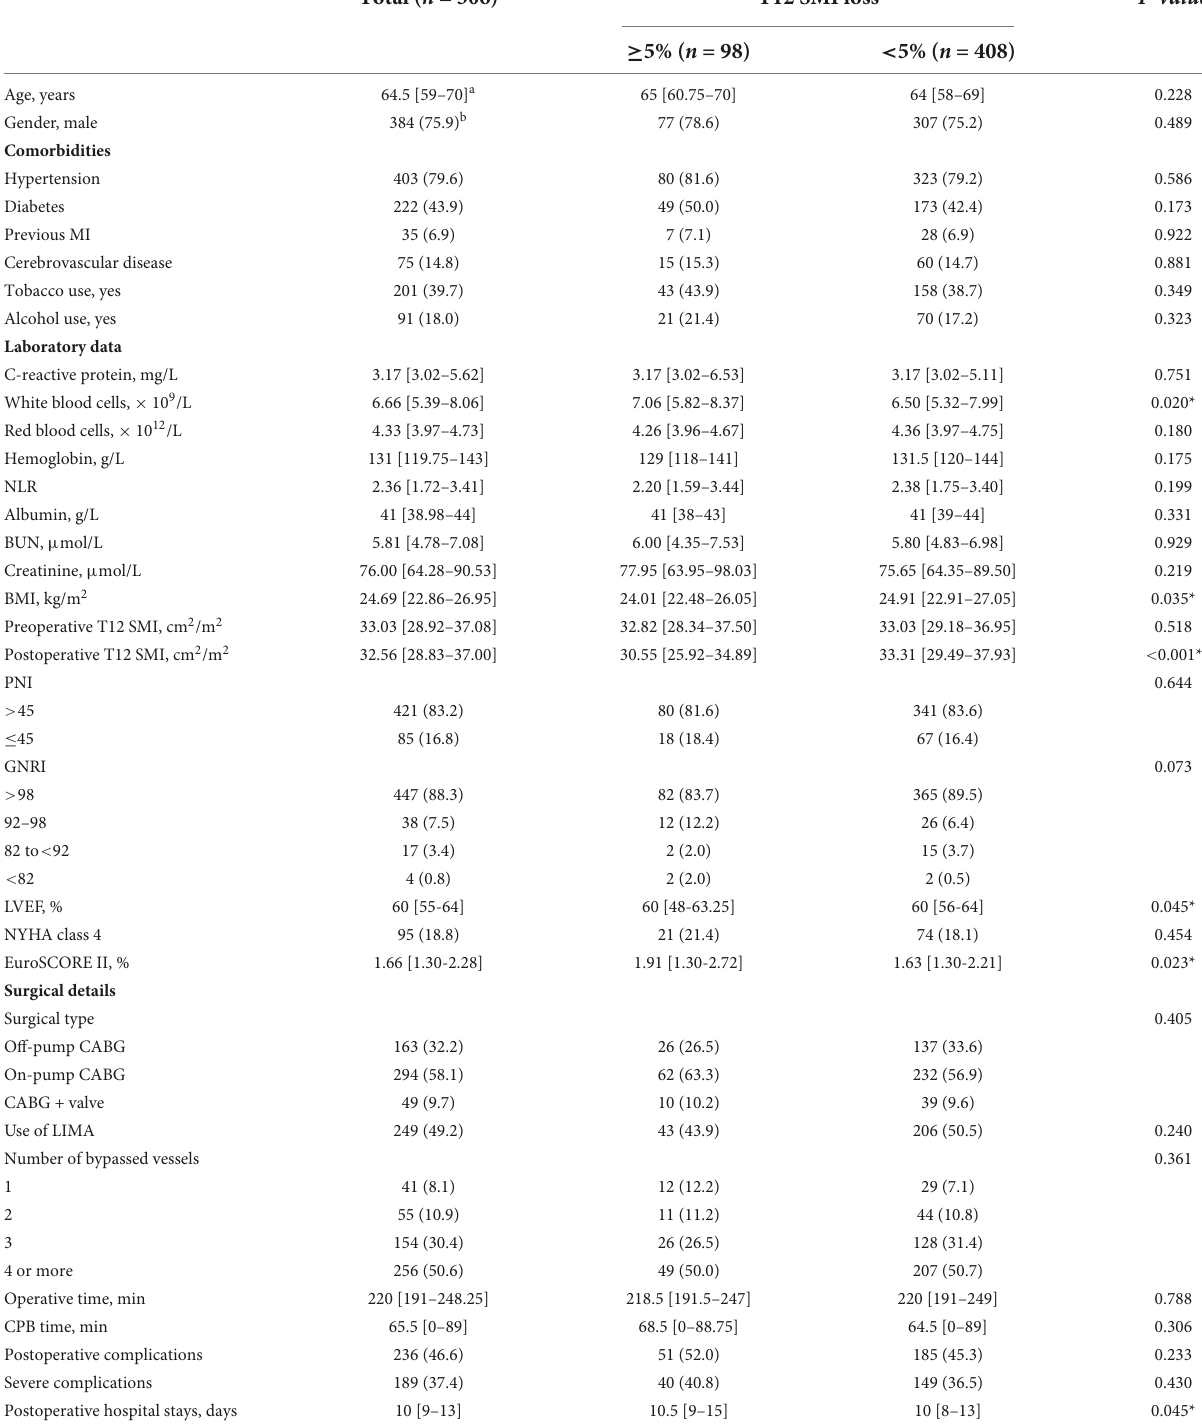
TABLE 1 Patient characteristics according to postoperative skeletal muscle mass